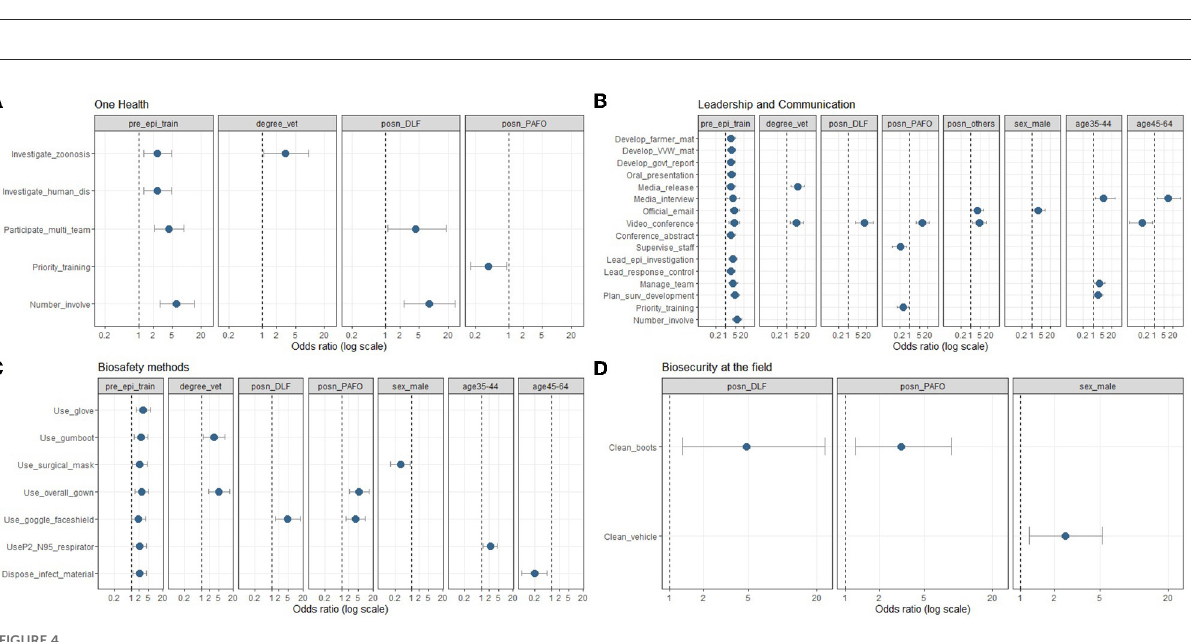
FIGURE4 Statistical significant associations ( p < 0.05) between skill outcomes and demographic variables for One Health (A) , leadership and communication (B) , biosafety methods (C) and biosecurity at the field (D) based on multivariable ordinal logistic regression models adjusting for age, sex and prior epidemiology training experience from an online veterinary epidemiology capacity cross-sectional study in Lao PDR between February and March 2021. The point estimate of odds ratio (OR) is depicted as a circle, with the error bar indicating the 95% confidence interval. Key labels on the y-axis: prog, program; dis, disease; mat, material; VVW, village veterinary worker; govt, government; epi, epidemiological; surv, surveillance; infect,